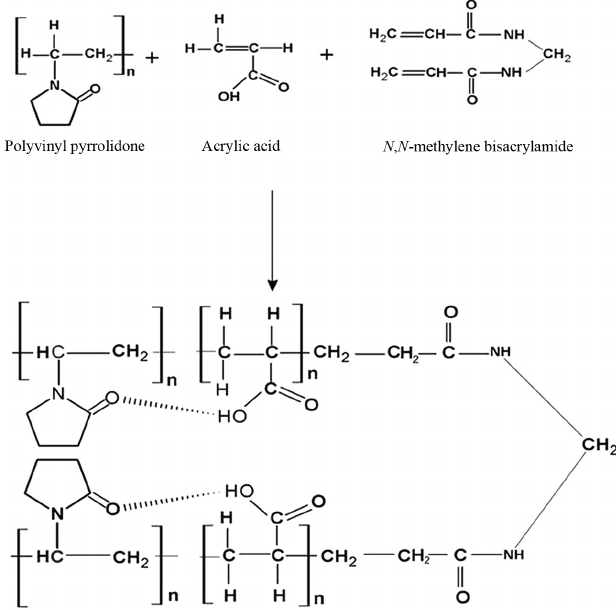
FIGURE 1 - Possible structure of polyvinylpyrrolidone/acrylic acid